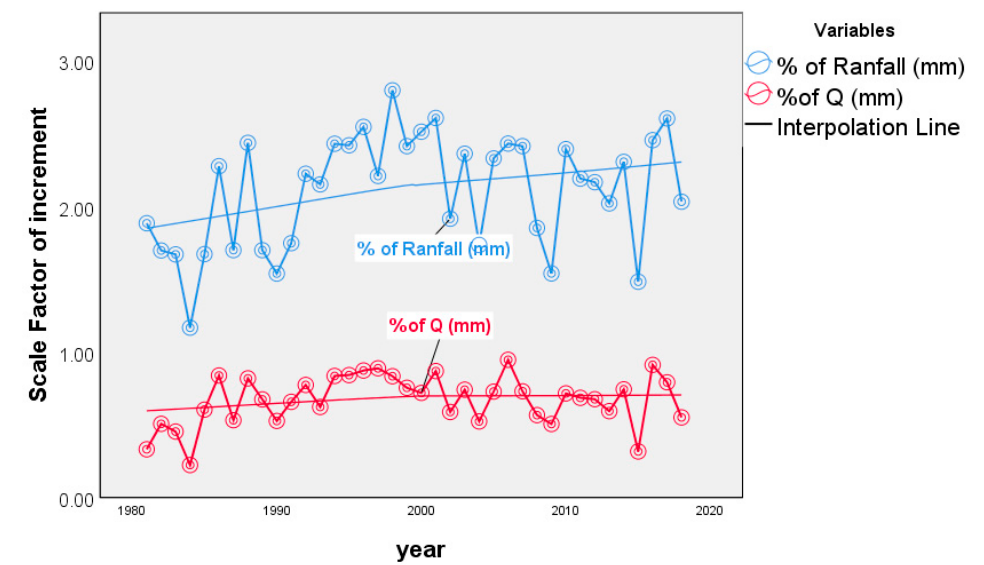
Figure 10. Temporal scale factor increments of percentage rainfall and percentage runoff (Q).